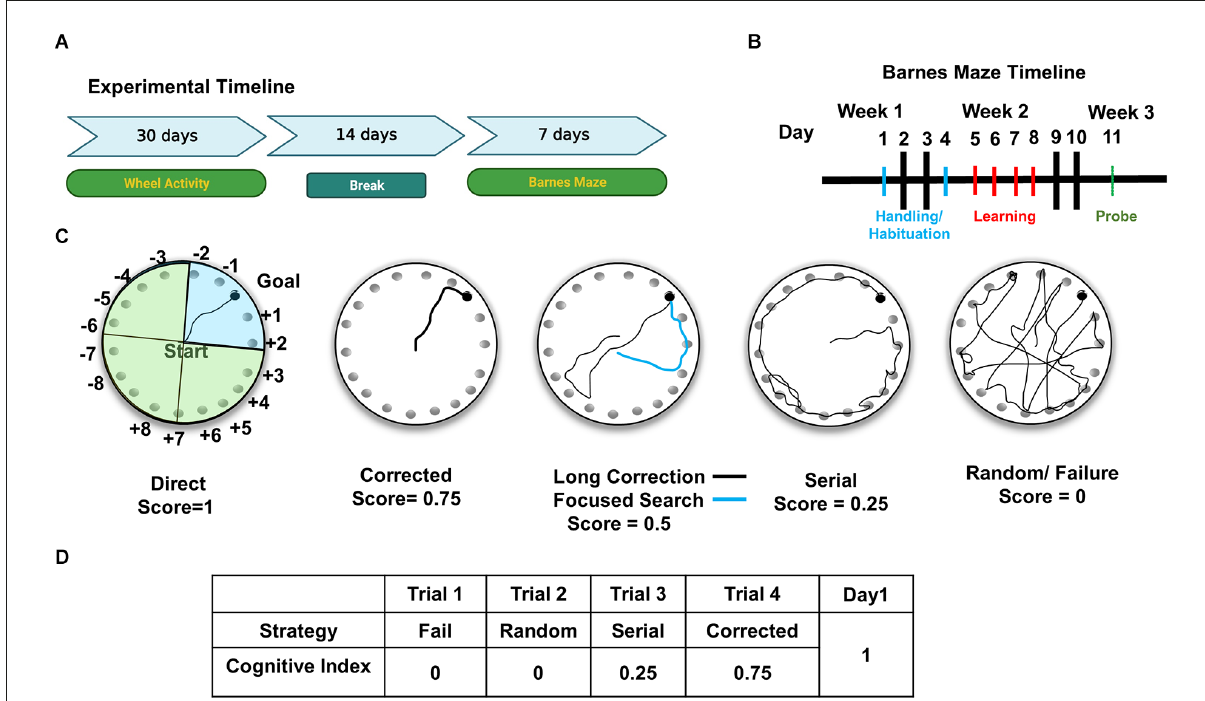
FIGURE1 Experimental design for cognitive and circadian behavior analysis. (A) For the experimental timeline, mice were first analyzed for circadian wheel- running activity, followed by Barnes maze testing. (B) Barnes maze testing consisted of 7 days of behavioral analysis, including habituation to the apparatus in days 1 and 2, training/learning of the position of escape hole (days 3–6), and a 72 h probe on day 7. (C) Schematic representation of the Barnes maze shows faux escape boxes (numbered) and goal location (escape box). For illustration purposes, maze is divided into four quadrants. Blue shaded quadrant is the target quadrant used for Probe analysis. Representative strategies are shown in each circular depiction of the Barnes. Spatial strategies include direct, corrected, long correction (black trace), focused search (blue trace). (D) Example of scoring of trials in Day 1 for a mouse. Cognitive indices are calculated per mouse by adding the scores from each trial for all 4 days.